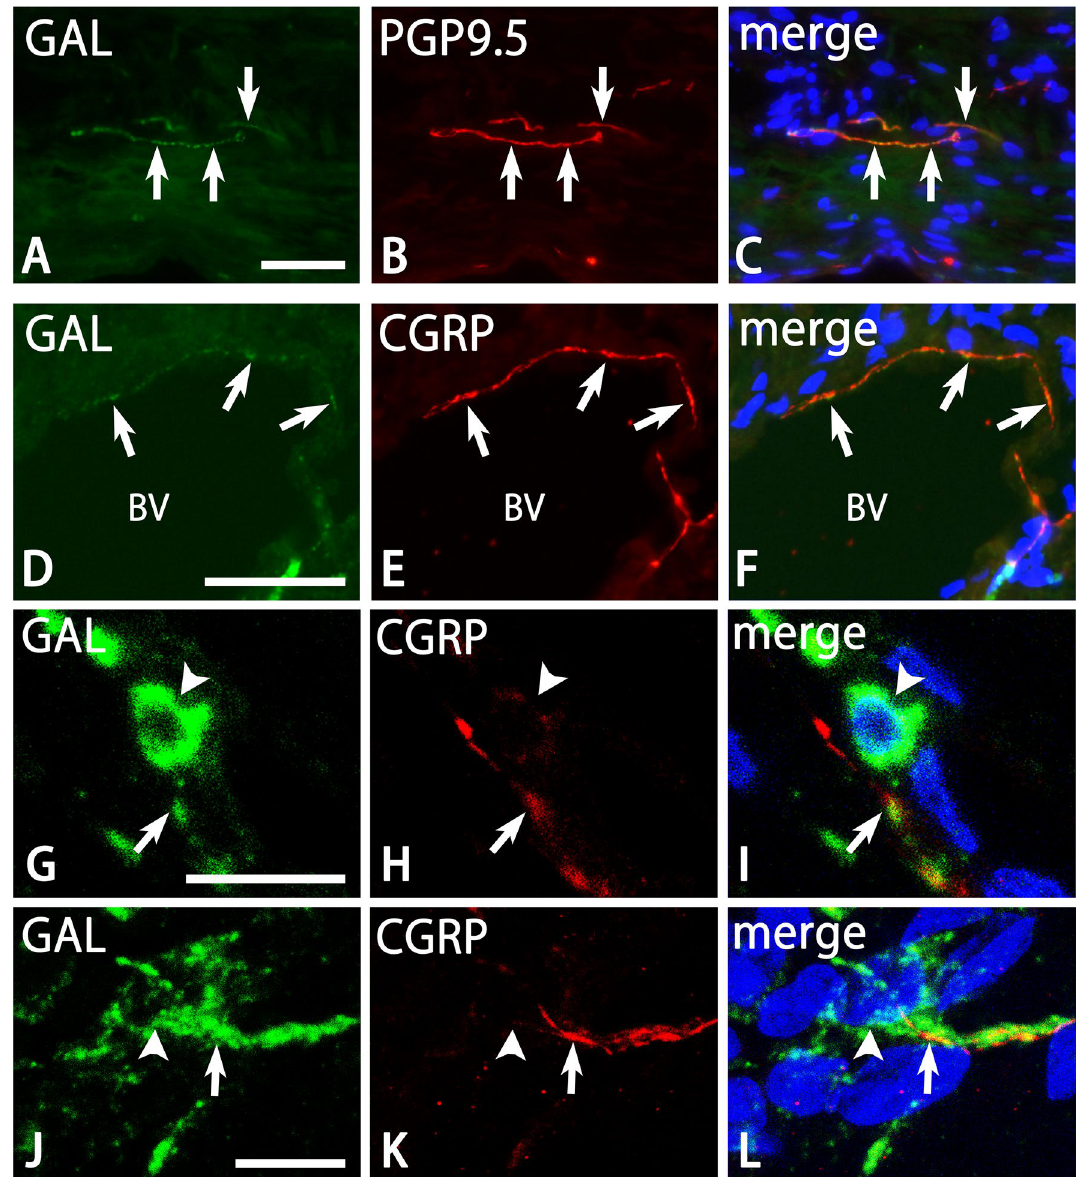
Figure 5. Photomicrographs for GAL ( A , D , G , J ), PGP9.5 ( B ), CGRP ( E , H , K ), and merged and DAPI ( C , F , I , L ) in the dura mater by a conventional fluorescence ( A – F ) and a confocal laser scanning ( G – L ) microscope. Panels ( A – C ), ( D – F ), ( G – I ), and ( J – L ) are from the same fields of view, respectively. Panels ( J – L ) were obtained from 13 sections, respectively, at 0.5 µm interval. Isolated ( A – C ) and perivascular ( D – F ) nerve fibers, and nerve fibers apposed to cells ( G – L ) with GAL- ( A , D , G , J ), PGP9.5- ( B , C ), and CGRP-immunoreactivity ( E , F , H , I , K , L ) show similar distributions. Arrowheads in ( G – I ) and ( J – L ) indicate round and oblong types of GAL-ir cells, respectively. Bars = 50 µm ( A , D ) and 10 µm ( G , J ). Panels ( A – C ), ( D – F ), ( G – I ), and ( J – L ) are at the same magnifications,